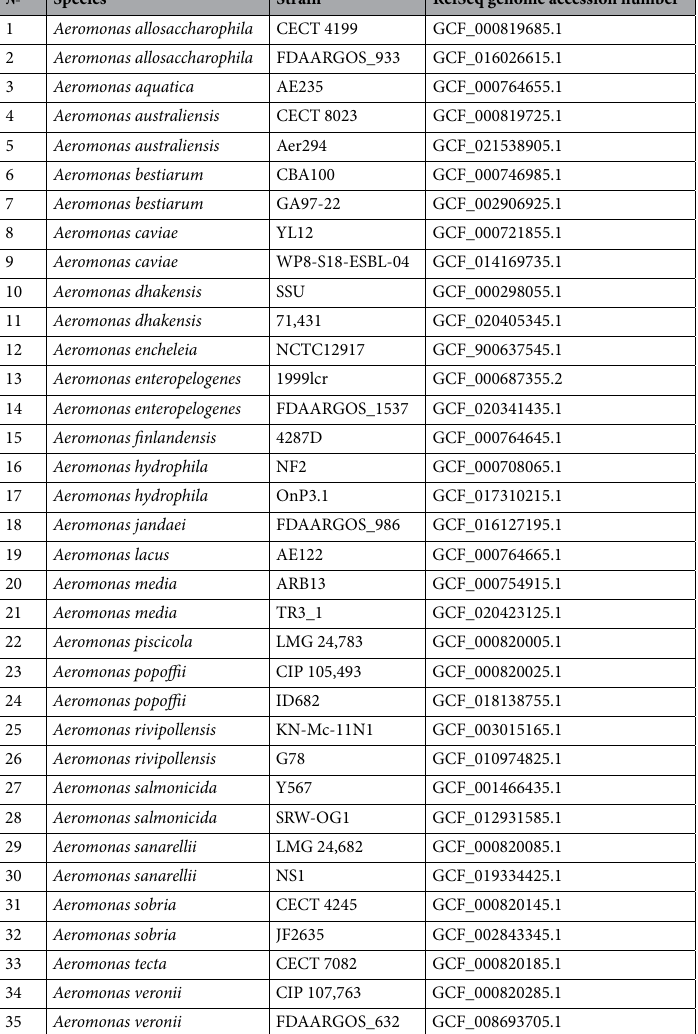
Table 2. The list of Aeromonas spp. strains used for phylogenetic